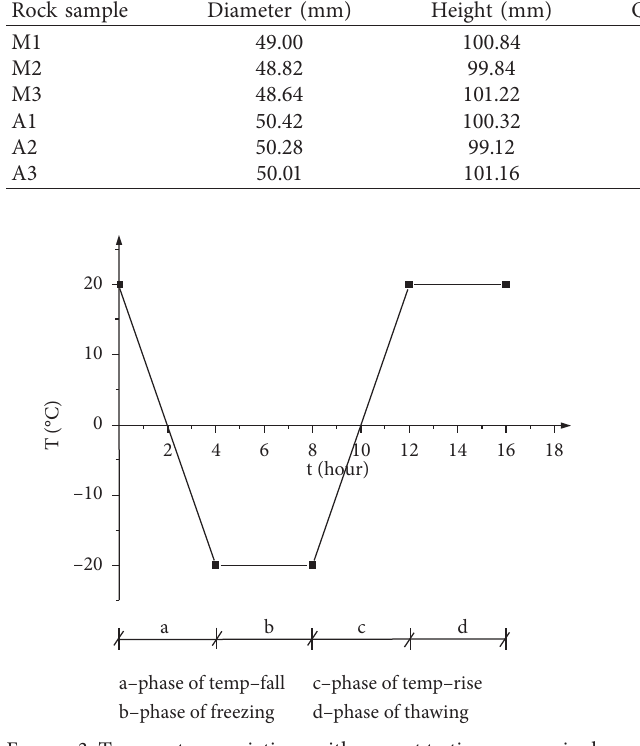
Figure 3: Temperature variations with respect to time over a single freeze-thaw